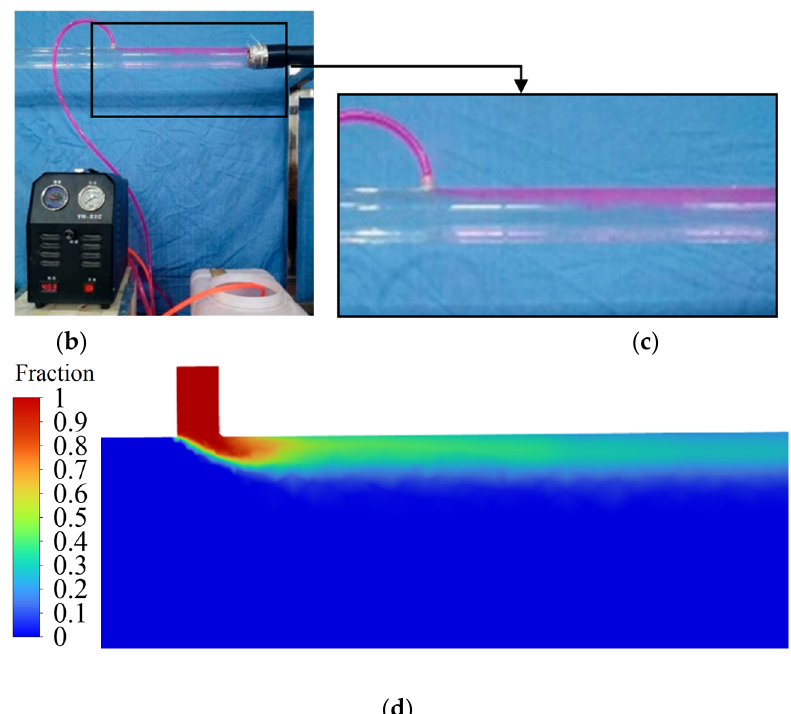
Figure 2. Comparison between experimental results [30] and numerical calculations: ( a ) schematic diagram of the experimental setup (I) tap water supply system, (II) jet control system, (III) mixed pipe; (1, 6) plastic water tank; (2, 5) centrifugal pump; (3, 10) ball valve; (4) electromagnetic flowmeter; (7) jet inlet; (8) acrylic visible pipe; (9) polyethylene (PE) pipe; ( b ) experimental result; ( c ) partial magnification of the experiment; ( d ) numerical calculation result.